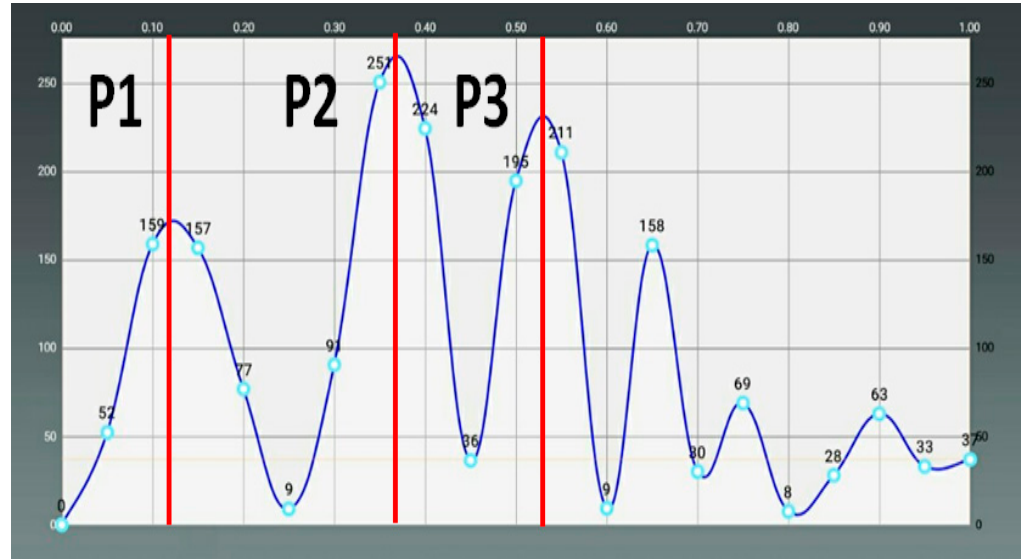
Figure 2. Implementation of graph using sectional peaks.